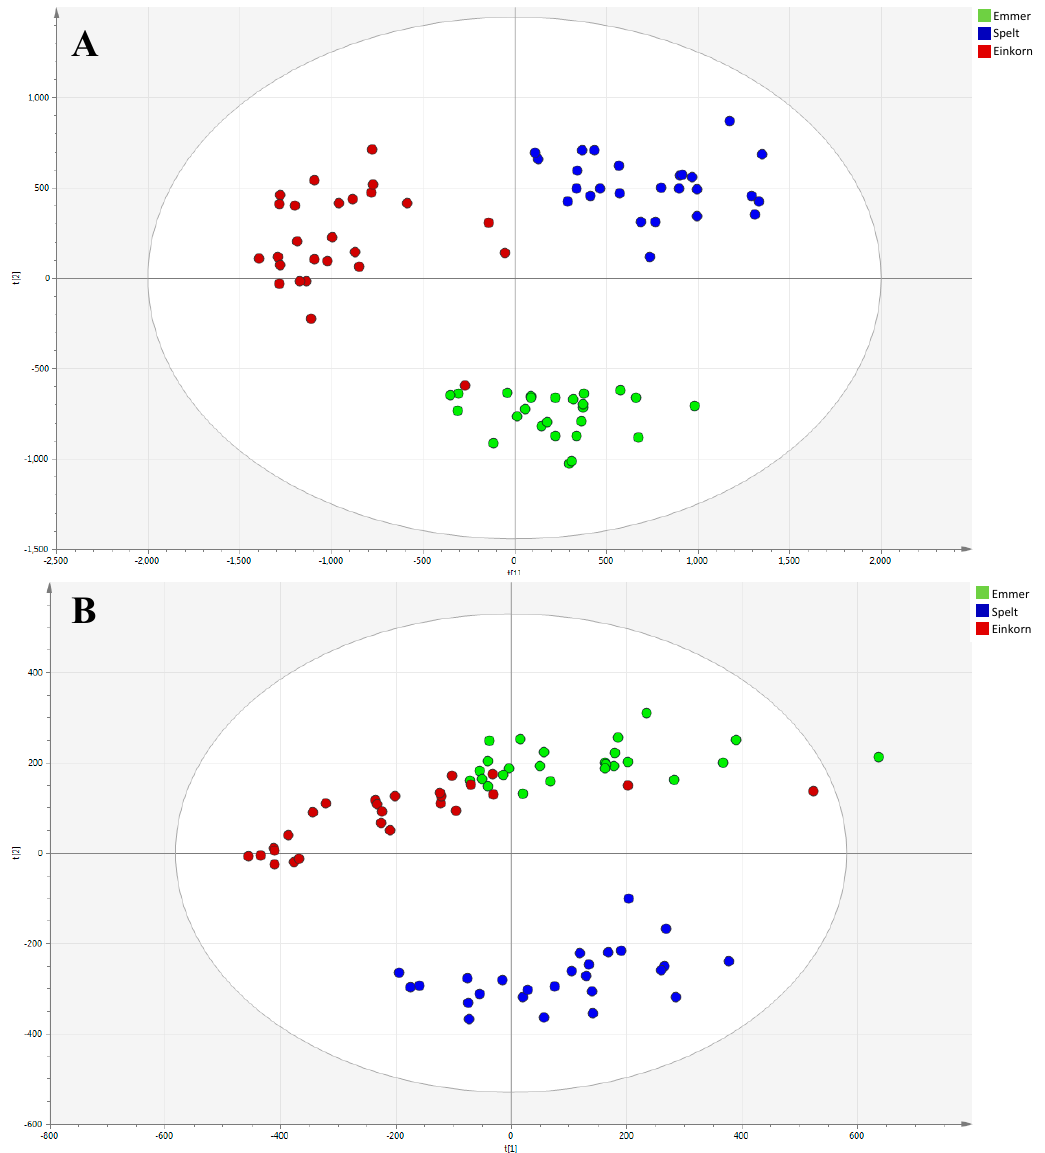
Figure 2. Unsupervised principal components analysis (PCA) models built from positive ( A ) and negative ( B ) ionization data set. Red dots: Einkorn (ID331). Green dots: Emmer (Garfagnana). Blue dots: Spelt (Rouquin).